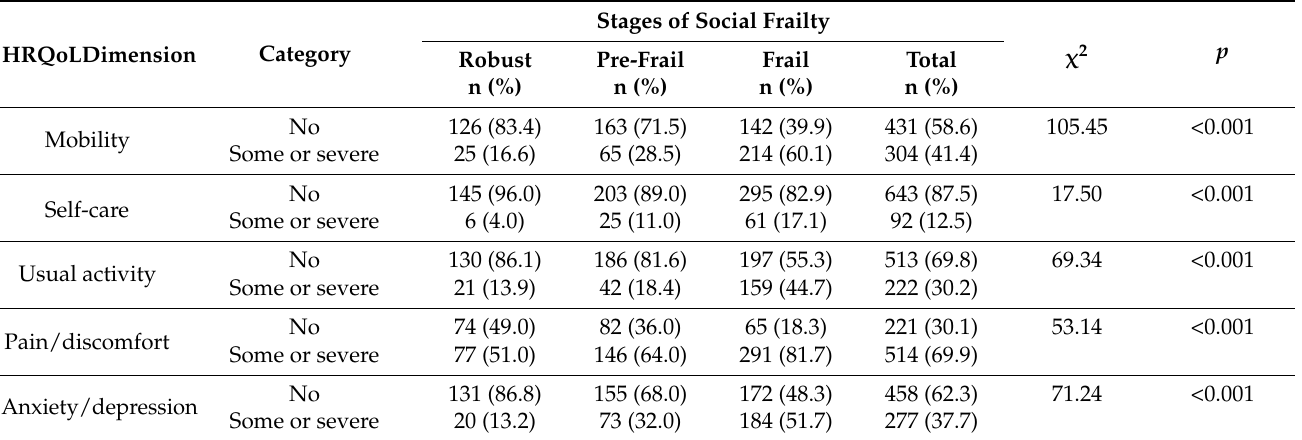
Table 3. Health-related quality of life dimension and social frailty stage; N =